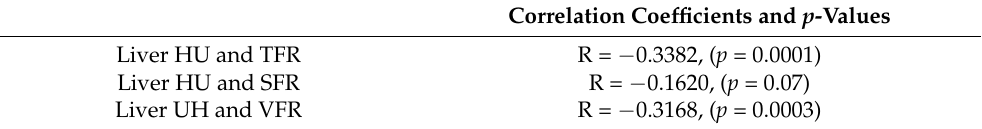
Figure 13. Variation of liver HU values. ( a ) Low HU value, ( b ) high HU value. Table 3. The correlation